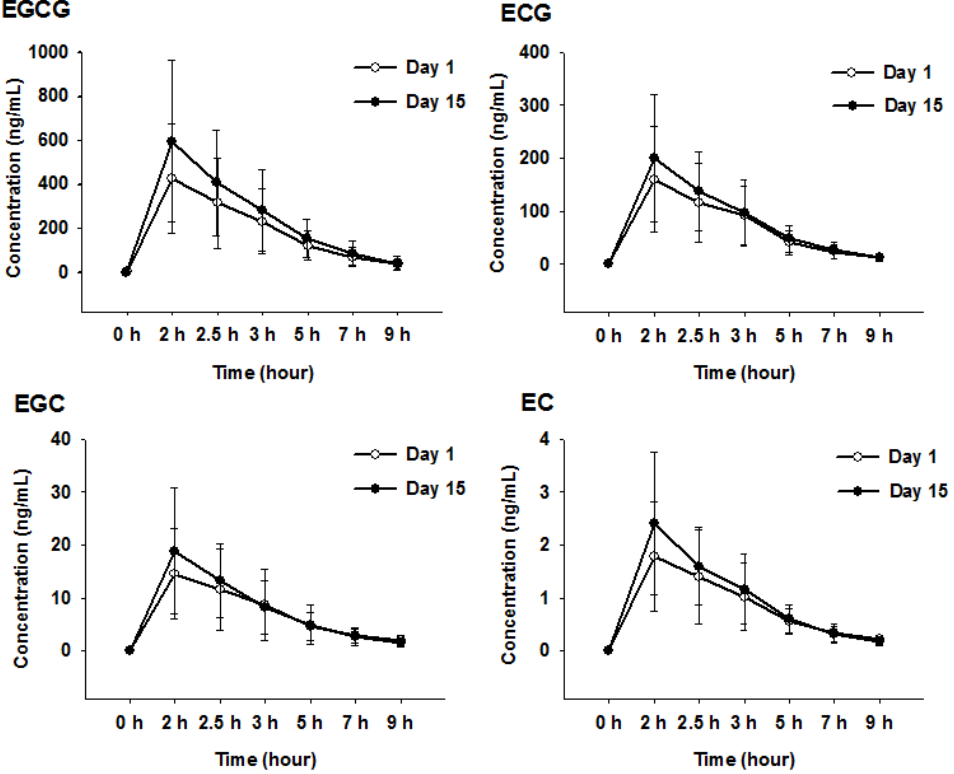
Figure 3. Mean plasma concentration-time profiles of four catechins after oral administration of 630 mg of green tea extract to healthy volunteers given once and continuously administered for 15 days. EGCG, epigallocatechin-3-gallate; ECG, epicatechin-3-gallate; EGC, epigallocatechin; EC, epicatechin. Day 1: Orally administered 630 mg of green tea extract with 0.5 mg digoxin in sixteen volunteers; Day 15: Repeated daily administration for 15 days of 630 mg green tea extract with a single administration of digoxin in fifteen